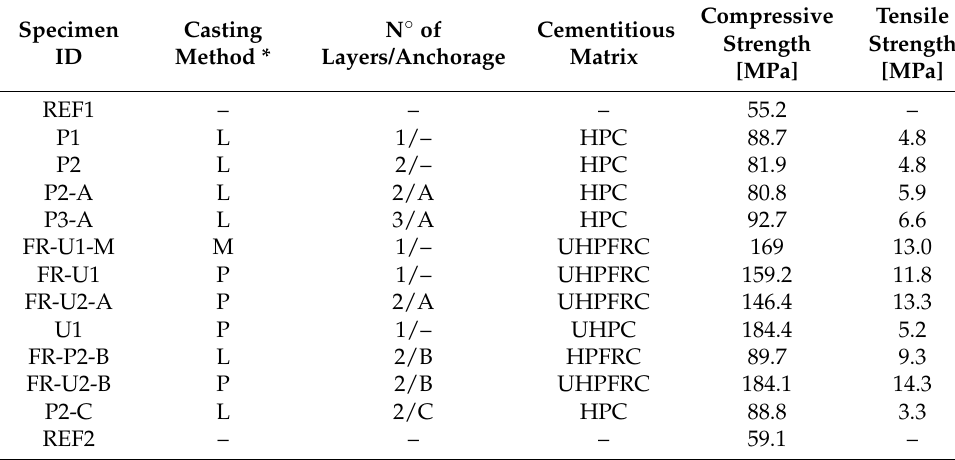
Table 1. Strengthening solutions and characteristics of the cementitious materials. Specimen*/-ID Casting Method *